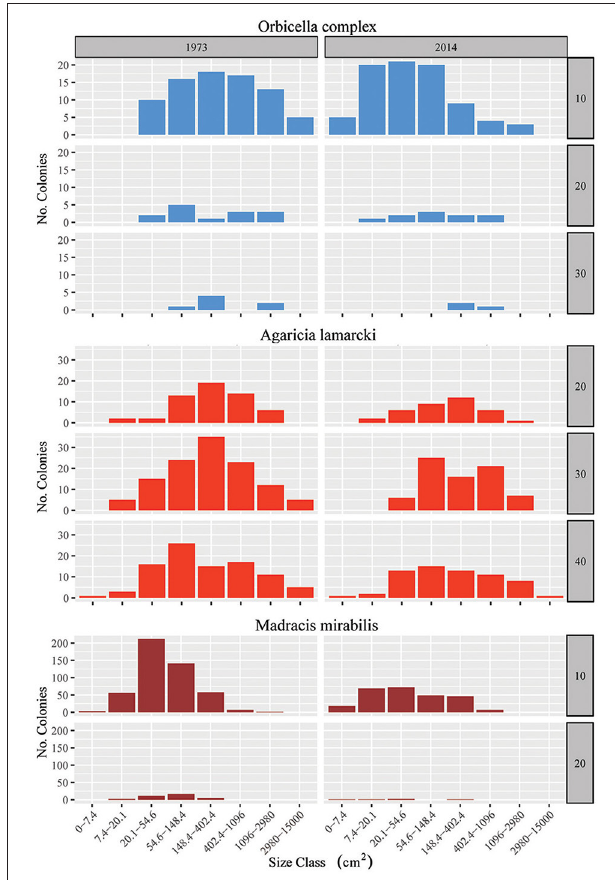
FIGURE 5 | Colony size frequency distribution for the three most prominent species: Orbicella spp., Agaricia lamarcki and Madracis mirabilis . Total number of colonies in 9 m 2 quadrats in 1973 (start time series) and 2014 (end) summed over the four main sites (I–IV) on a log scale (8 size classes), at different depths (when the species was present). Scale size varies for the different species. Species color codes correspond to the colors given in Fig. 4. For supporting data, also on the other species, see Figure S1 and Tables S2, S3.